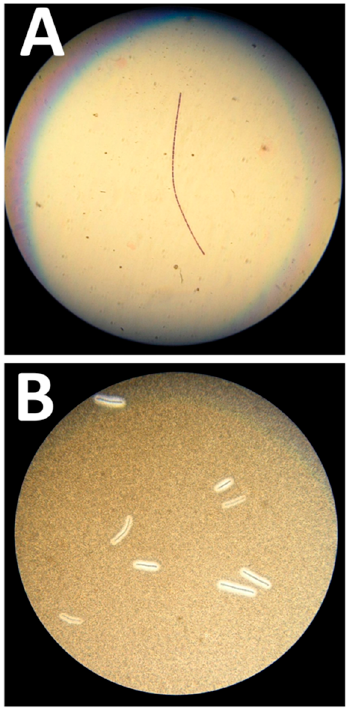
Figure 1. Microbiological features of the Bacillus anthracis strain. ( A ) Gram-positive “jointed bamboo- rod” bacilli forming long chains pathognomonic of B. anthracis . ( B ) Black ink negative staining of the B. anthracis bacilli capsule. The capsule repels the ink around the bacilli chains.